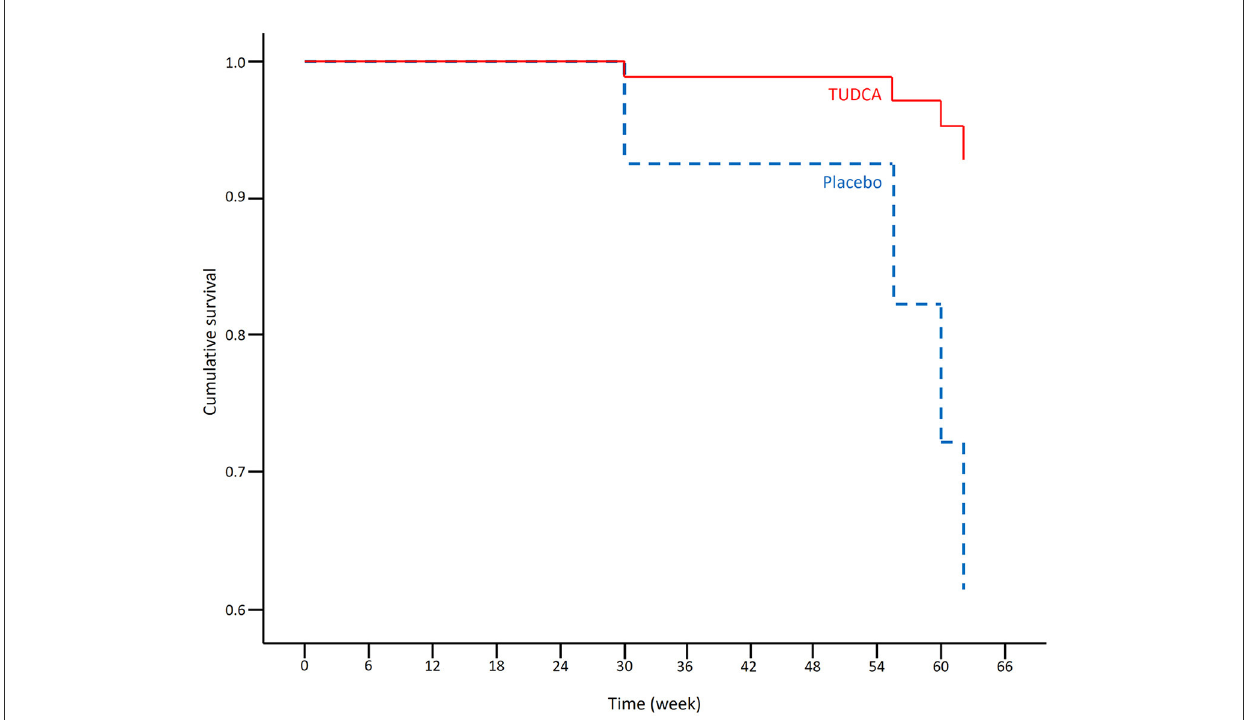
FIGURE1 Cox regression survival plot estimating the probability of survival in the placebo (blue dashed line) and TUDCA (red solid line) arms (HR = 0.051, 95% CI =